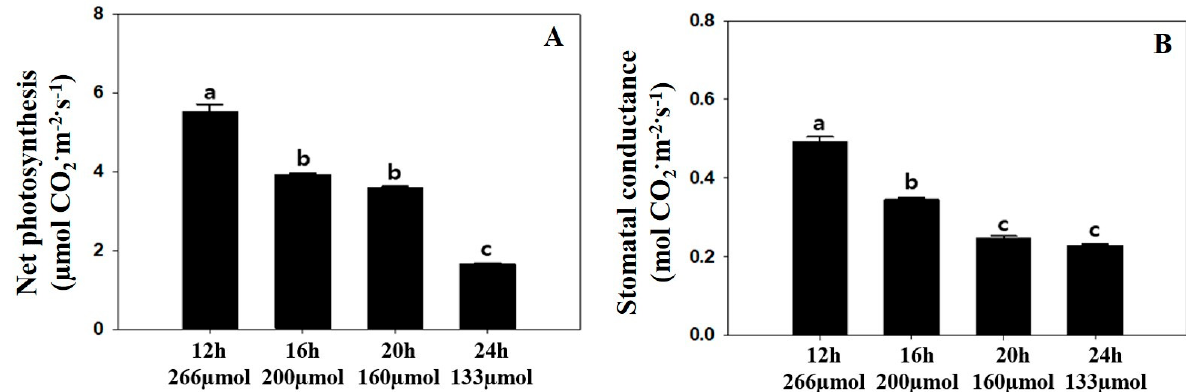
Figure 2. The net photosynthesis ( A ) and stomatal conductance ( B ) under different lighting treatments of 12 h—266 µmol . m − 2. s − 1 , 16 h—200 µmol . m − 2. s − 1 , 20 h—160 µmol . m − 2. s − 1 , and 24 h—133 µmol . m − 2. s − 1 . Different letters above bars show significant differences at p ≤ 0.05, using Tukey’s multiple range test ( n = 4).